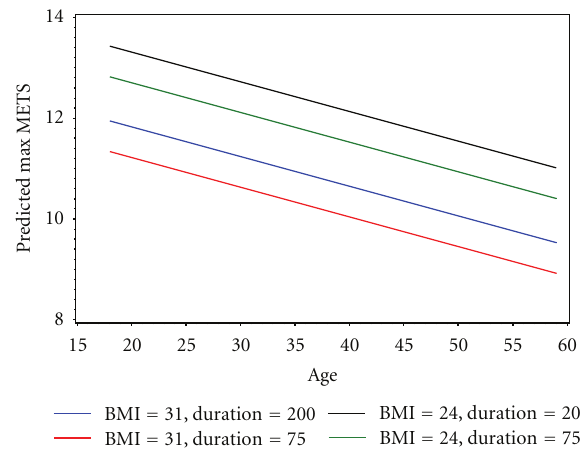
Figure 3: Predicted maximal Cardiorespiratory fitness (CRF) over the age span with the model calculated with the training set.